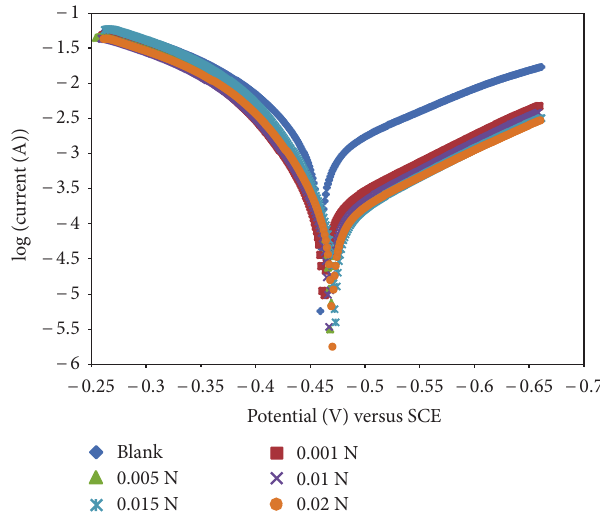
F 7: Potentiodynamic polaraisation curves of ACMU for mild SO . steel in 1N H 2 4